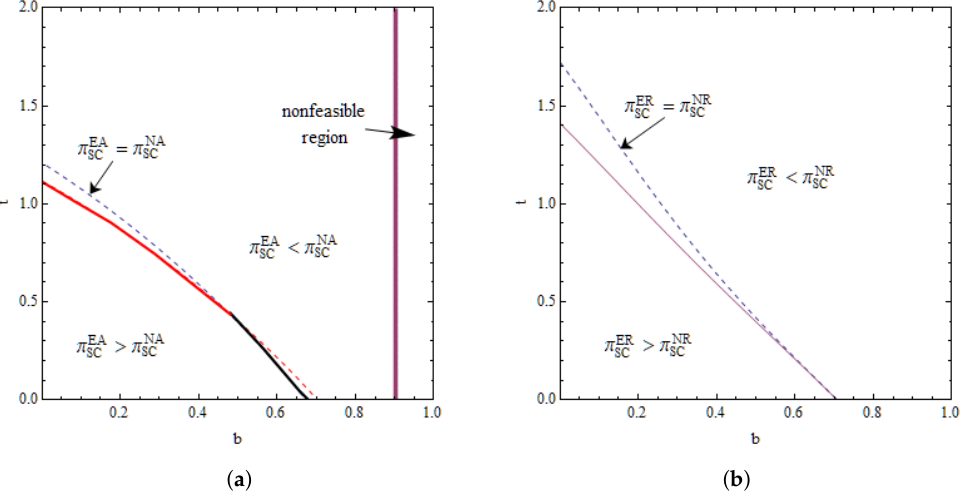
Figure 4. The profit change of the whole supply chain ( a = 0.5, r = 0.2, c = 0.1). ( a ) under the agency mode. ( b ) under the reselling